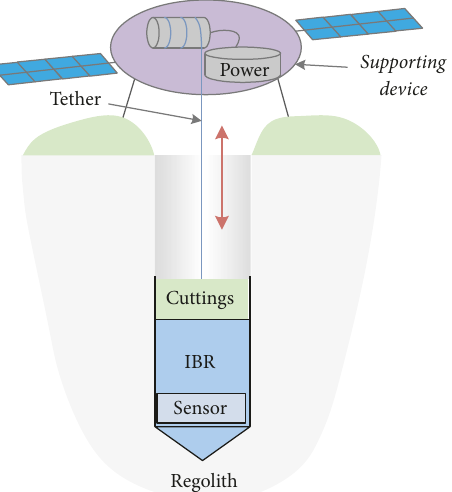
Figure 1: Subsurface exploration